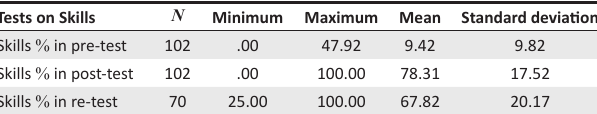
TABLE 4: Registered nurses’ cardiopulmonary resuscitation